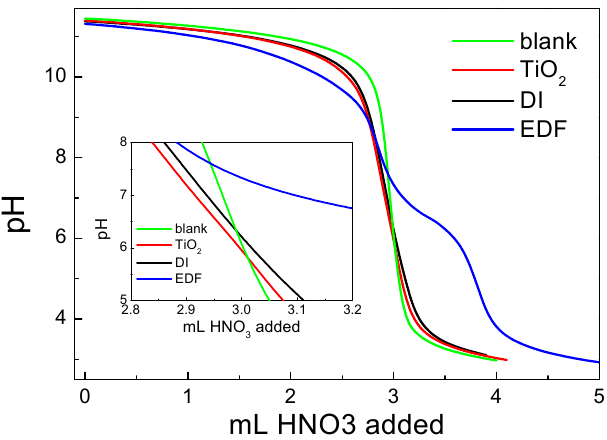
Figure 8. Potentiometric mass titrations for the prepared catalysts, TiO 2 and the blank solution. Inset: the section points of titration curves of each suspension with blank solution, corresponding to the point of zero charge (pzc) of each solid.